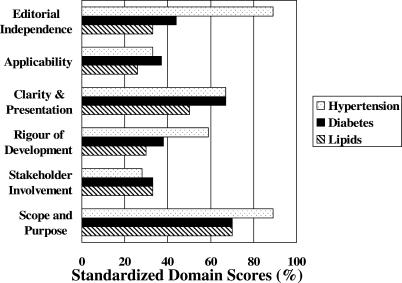
Summary of AGREE Domain Scores for Guidelines, Averaged over Each Condition